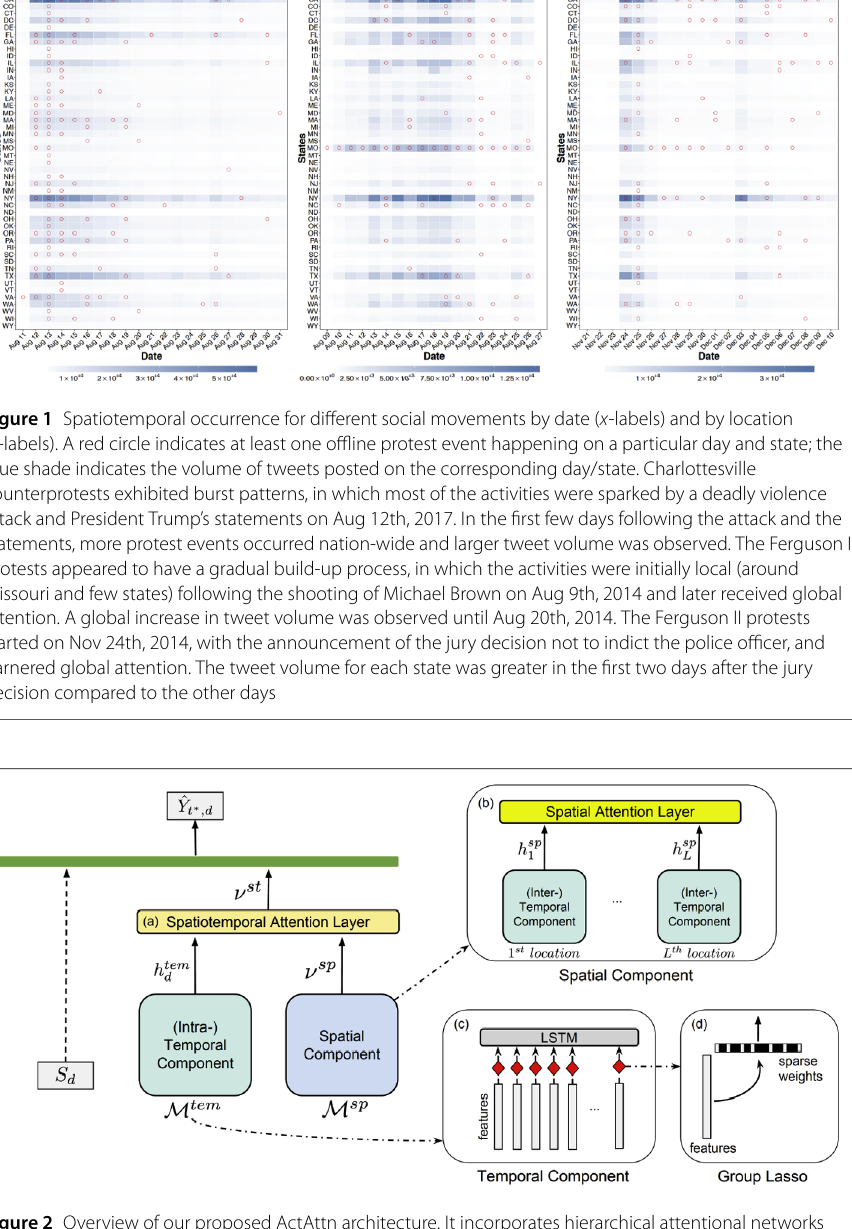
( b ) identifies the hub regions. The temporal dependency of time-varying features in both intra- and inter-regions are modeled using LSTM ( c ), with sparse feature learning using Group Lasso ( d